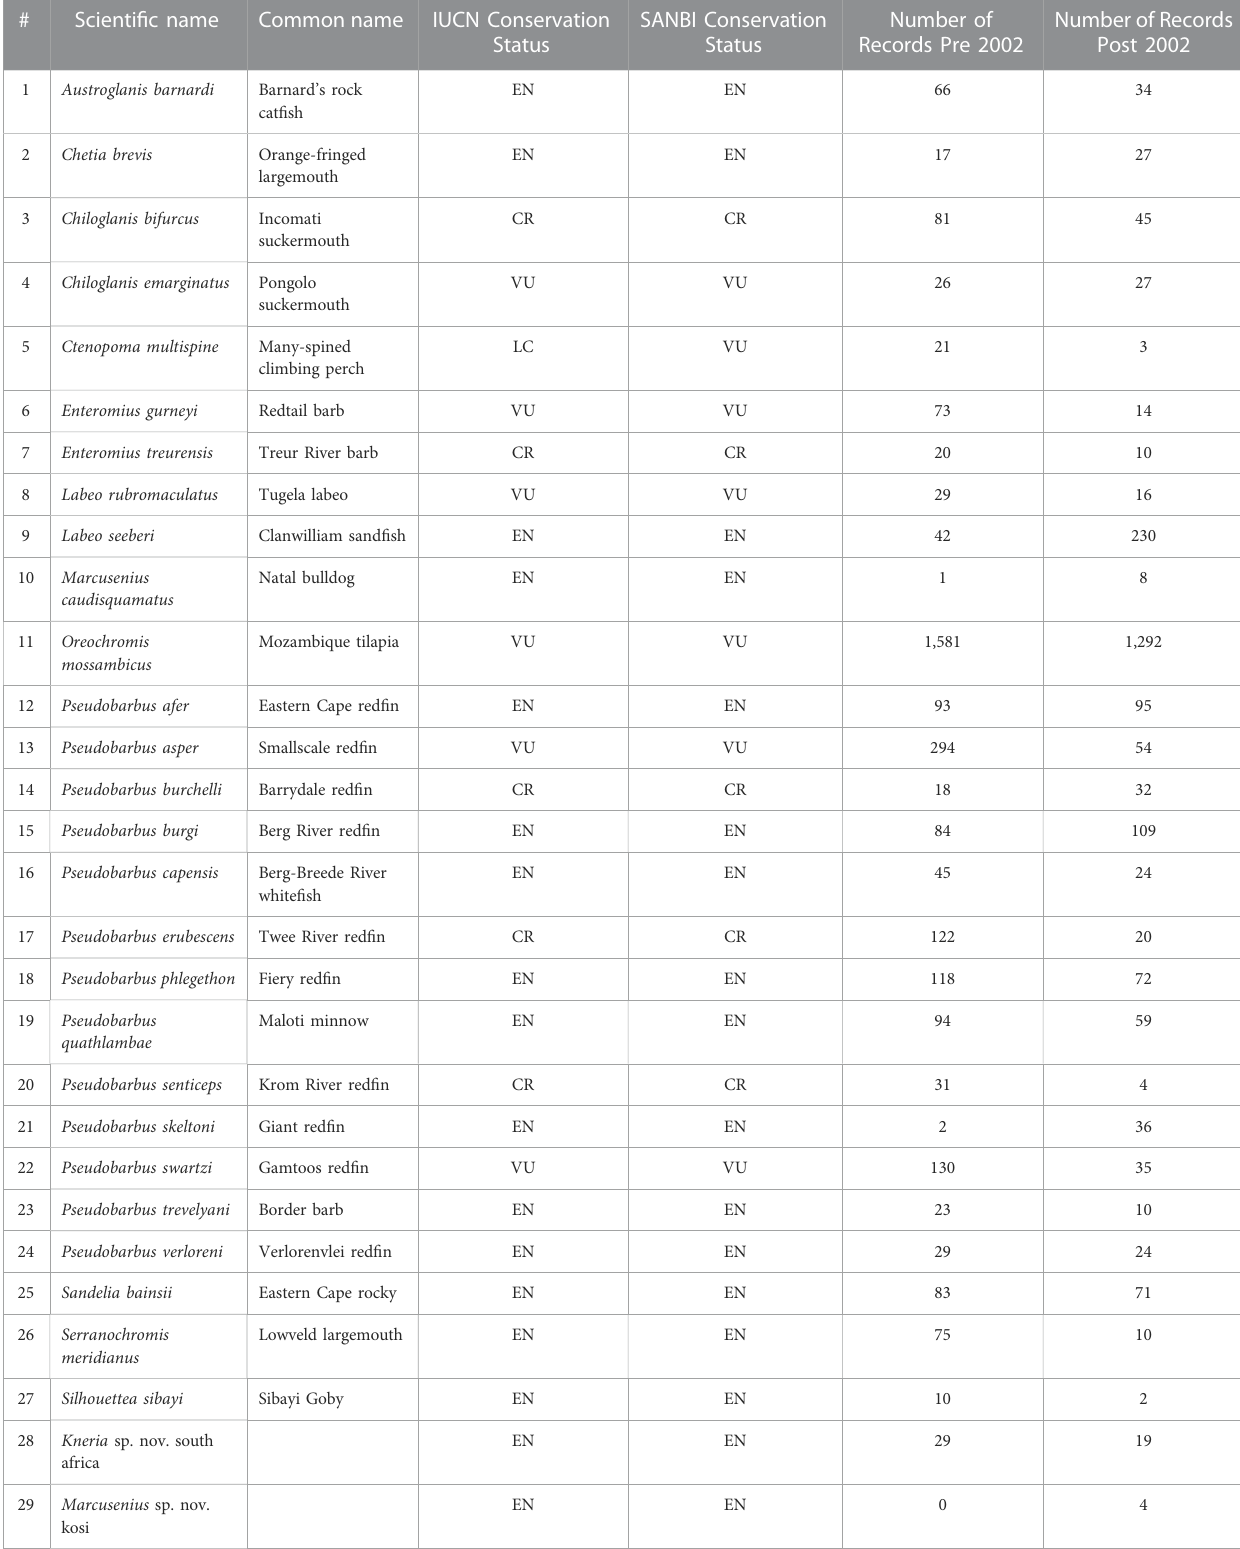
TABLE 1 List of threatened (Vulnerable, Endangered and Critically Endangered) South African freshwater fi sh taxa included in the NEST analysis. Conservation status and the number of occurrence records sourced from the Freshwater Biodiversity Information System (FBIS) pre and post 2002 are shown. Taxa #1 – 27 are formally-describes species, while taxa #28 – 34 represent recognised genetically-distinct lineages. Threat categories are: VU = Vulnerable; EN = Endangered; CR = Critically